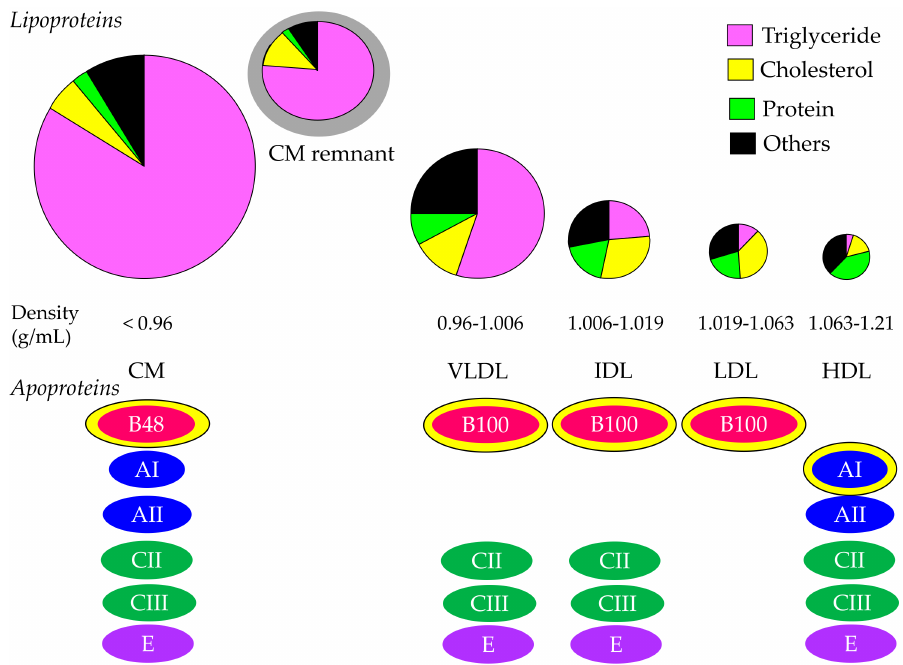
Figure 1. Composition and apoproteins included in each lipoprotein. Yellow–bordered apoproteins indicate that they are the main apoproteins in each lipoprotein. CM, chylomicron; HDL, high– density lipoprotein; IDL, intermediate–density lipoprotein; LDL, low–density lipoprotein; VLDL, very–low–density